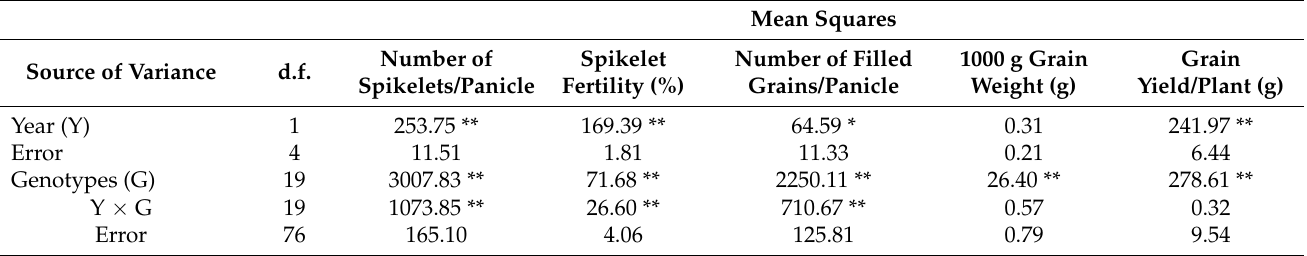
Table 7. The combined analysis of yield and its components of twenty rice genotypes over the two years.